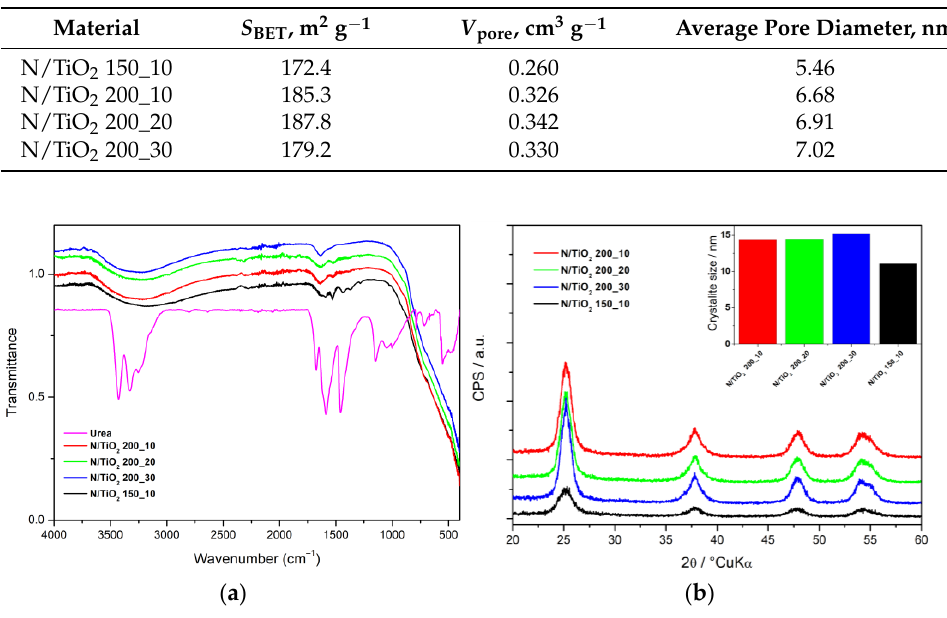
Figure 1. ( a ) FTIR spectra of N/TiO 2 materials, and ( b ) X-ray diffraction patterns, crystallite size.